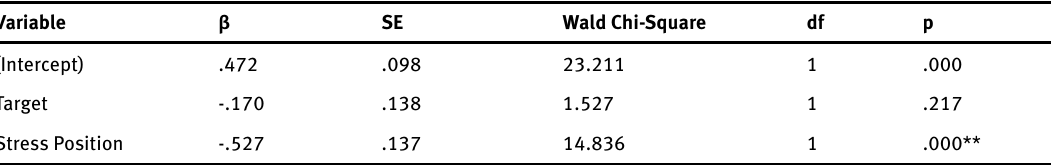
Table 11 Regression analysis by stressed